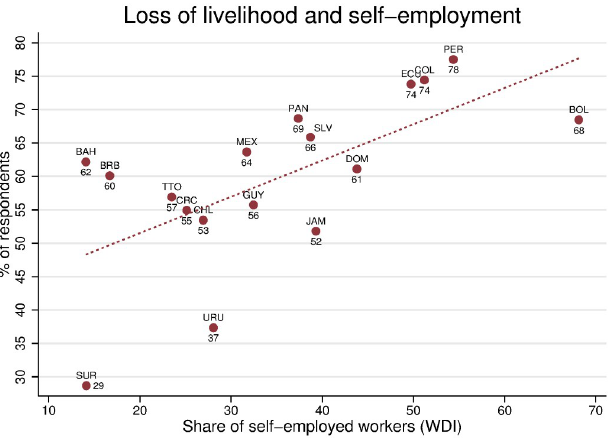
Fig 2. Higher rates of livelihood loss in countries with higher informality. Each dot represents the share of respondents who report that a household member lost a job or closed a business. Data is weighted using within- and cross-country weights. See Empirical Methods in the Supplementary Information section for